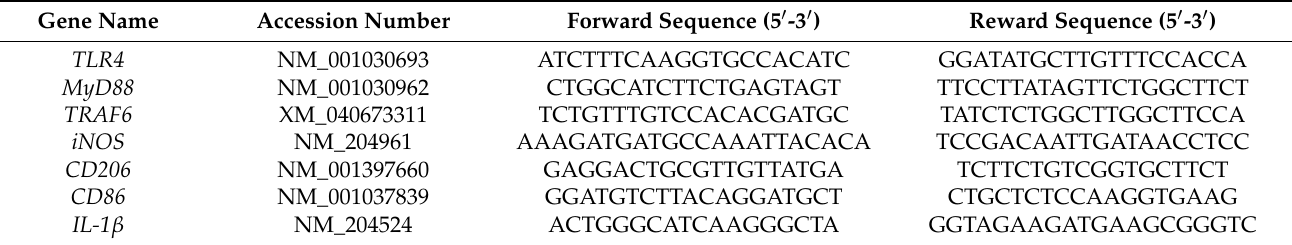
Table 1. The primers used in this